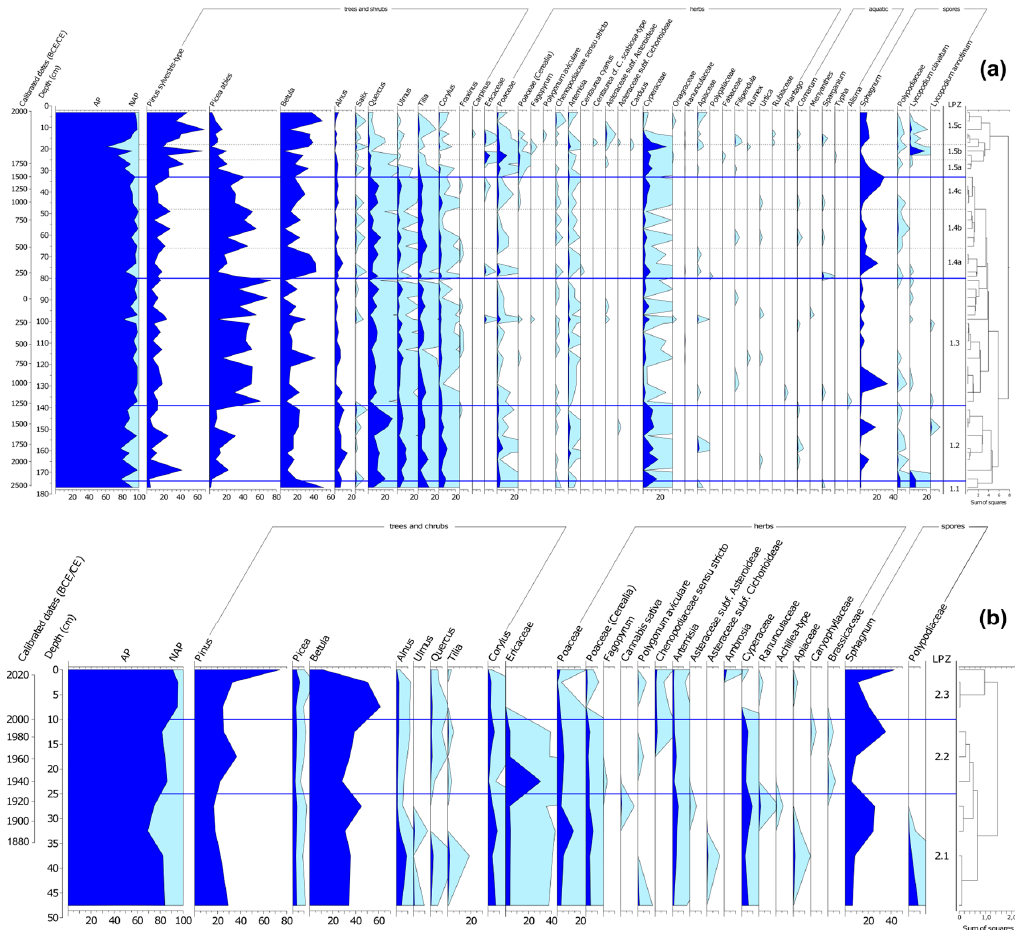
Figure 6. Pollen diagram of the peat core from deposits in the Gorenki mire in the undisturbed deposits ( a ) and in the floating mat ( b ). Zones (LPZ1.1–LPZ 1.4 and PMF2.0–PMF2.3) with homogeneous composition of pollen spectra were distinguished based on the constrained incremental sum of squares. The participation of pollen taxa is presented as a percentage of the pollen sum, and spore taxa as a percentage of the pollen and spore sum (the light blue polygons are percentages ×10). BCE—Before Common Era, CE—Common Era.